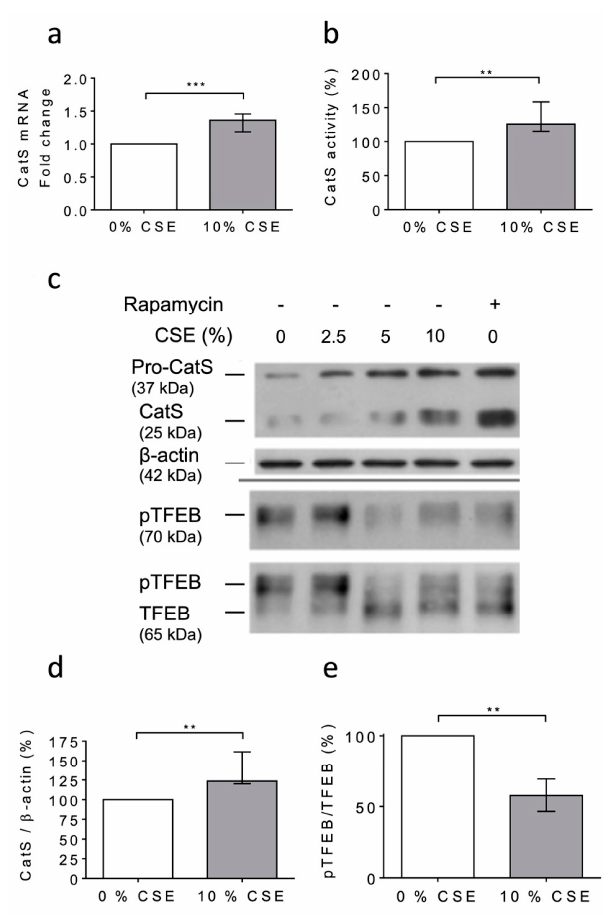
Figure 3. Cigarette smoke extract (CSE) triggered the expression and secretion of active CatS in THP1 cells through the mTOR/TFEB signaling pathway. ( a ): At day 6 after differentiation of THP1 monocytes into macrophages, CSE (10%) was added for 12 h. CatS transcription was analyzed by RT-qPCR. Data are expressed as relative fold change compared to the untreated control. ( b ): Peptidase activity of secreted CatS was measured using Z-Leu-Arg-AMC (20 µ M) as substrate. ( c ): Macrophages were treated or untreated by CSE (10%) or rapamycin (50 nM) during 12 h. Protein levels (cell lysates) of CatS, β -actin, pTFEB (Ser 211), and TFEB were analyzed by Western blot analysis ( β -actin, load control). A representative sample of five independent experiments is shown. ( d ): Densitometric analysis of the level of immunoreactive CatS (control: 0% CSE). ( e ): Densitometric analysis of the pTFEB/TFEB ratio (control: 0% CSE). For Figure 3d,e, normalized data correspond to the average of five independent WB experiments. Bars represent median ± quartile. Statistical significance was assessed using Mann–Whitney test (** p < 0.01; *** p <